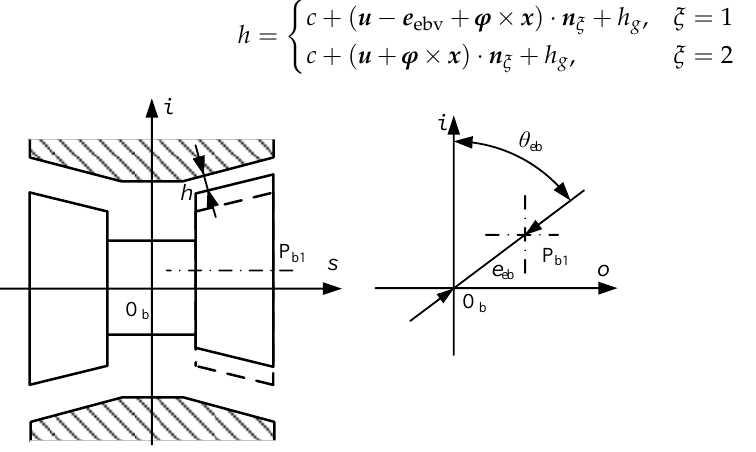
Figure 5. Schematic of eccentric error of bearing installation axis.